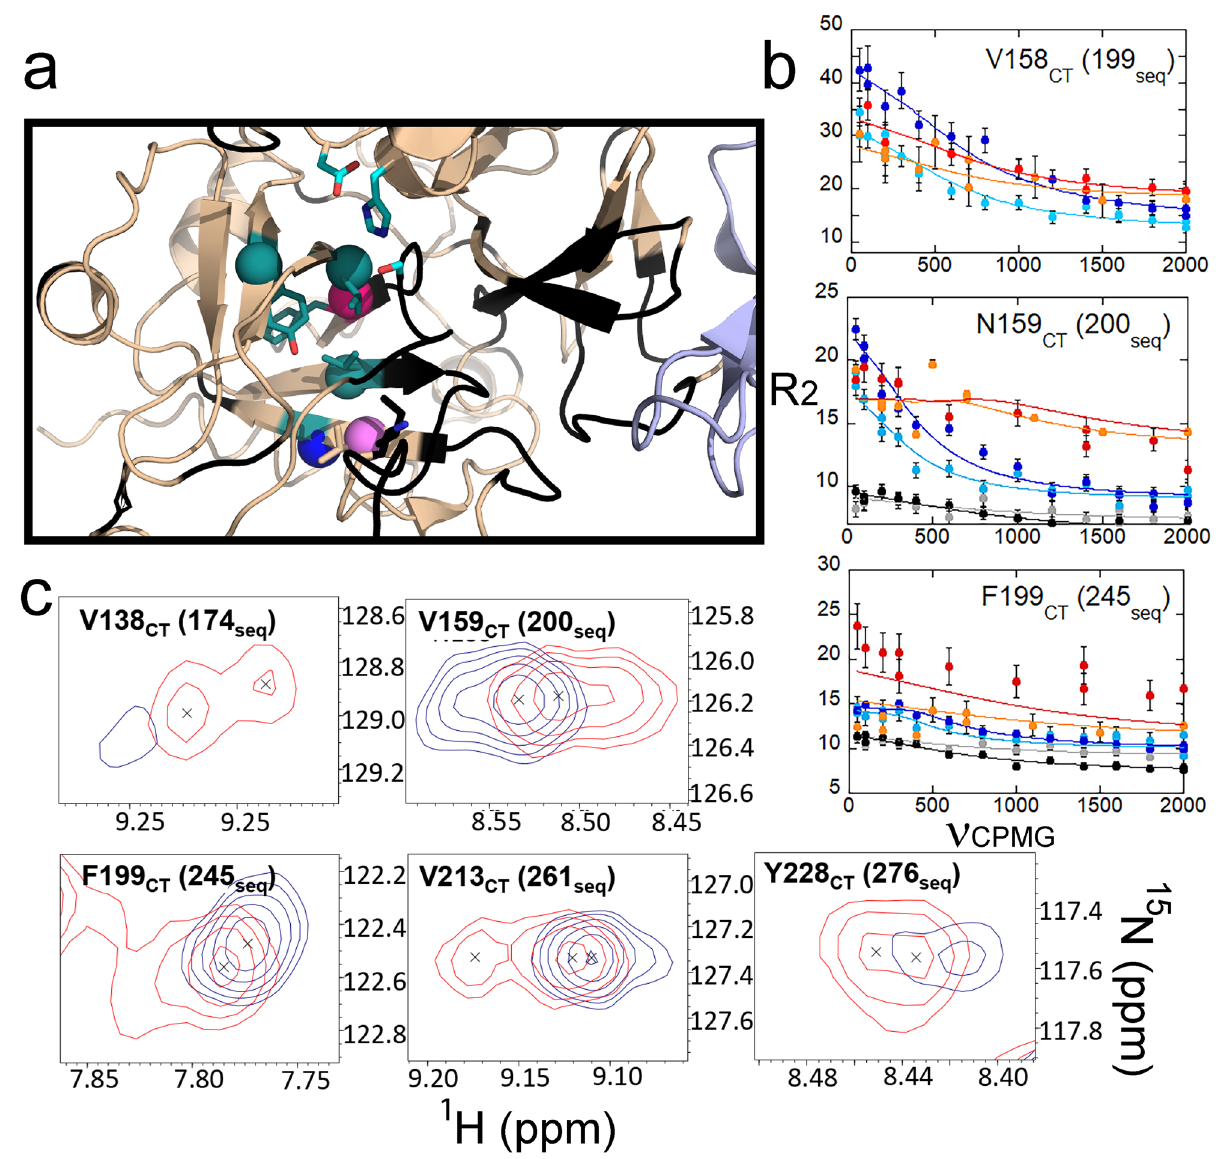
Figure 4. ( a ) Structure of thrombin (wheat) bound to TM456 (light blue) [PDB ID: 1DX5] showing the C-terminal β-barrel. Residues with missing resonances (black), doublet resonances (teal spheres), resonances experiencing increased μs-ms dynamics (pink spheres), resonances experiencing similar μs-ms dynamics (violet spheres) and resonances experiencing decreased μs-ms dynamics (blue spheres) in thrombin-TM456 compared to apo-thrombin are shown. ( b ) CPMG plots for resonances in the thrombin C-terminal β-barrel (symbols as in Fig. 1). ( c ) Examples of thrombin-TM456 HSQC (red) doublet resonances compared to apo-thrombin (blue)